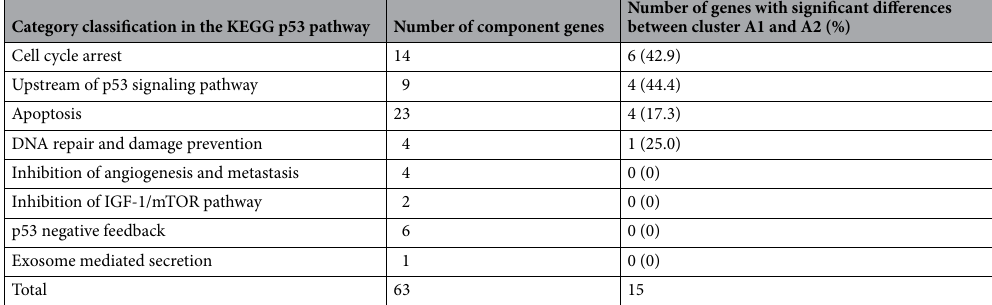
Category classification in the KEGG p53 pathway Number of component genes